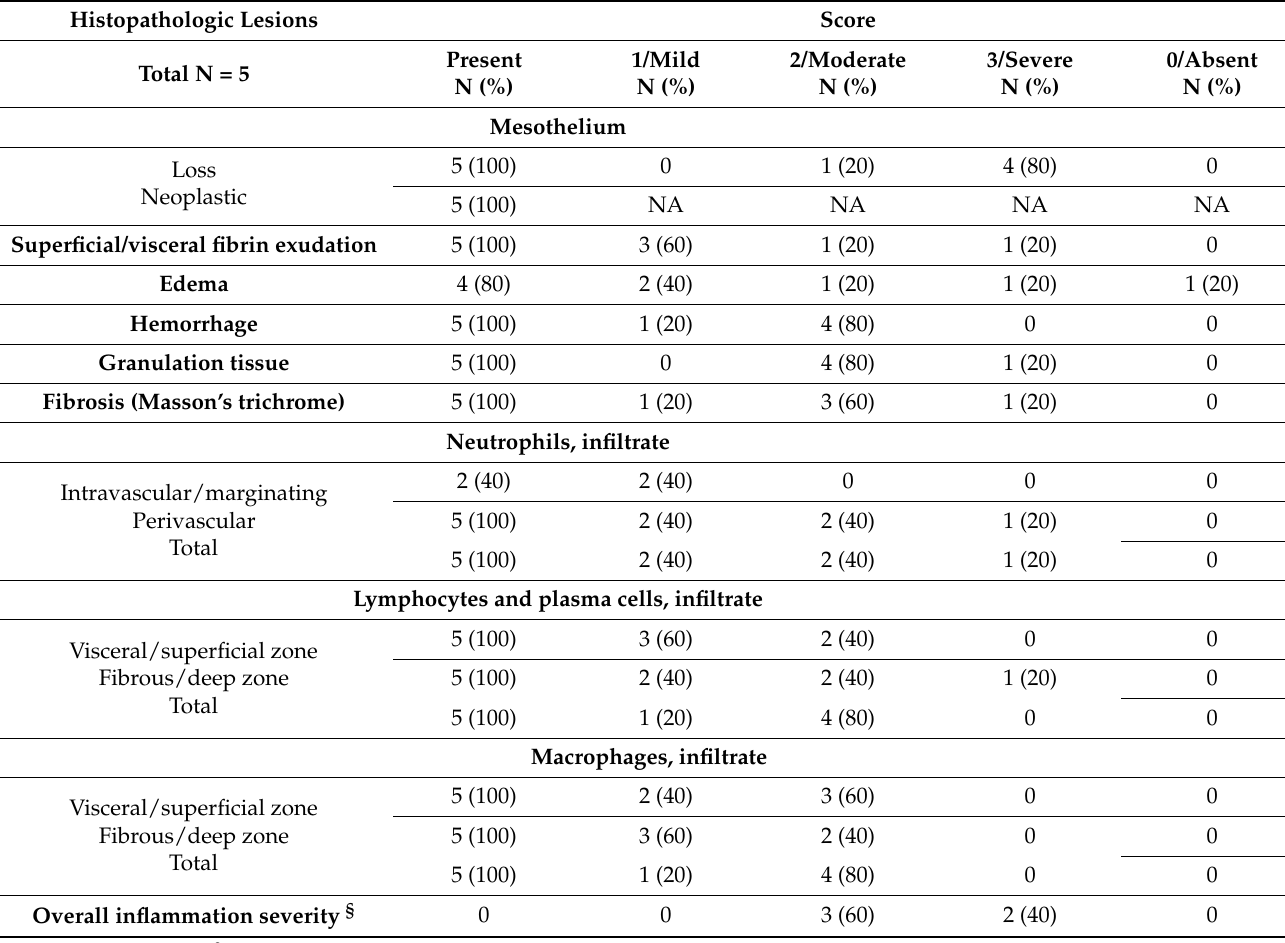
Table 3. Histopathologic lesions in pericardia affected by mesothelioma. Evaluated on H&E sections, except fibrosis which was scored in Masson’s trichrome-stained